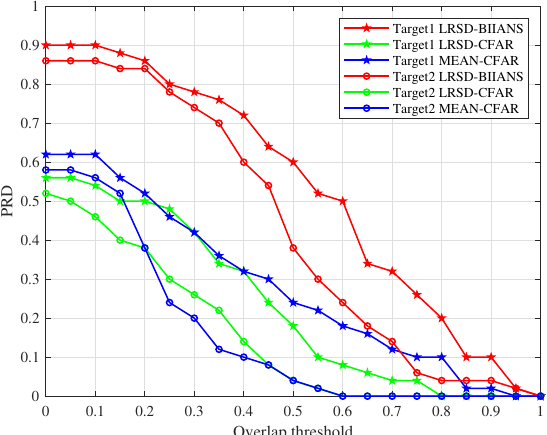
Figure 12. Comparison of detection integrity of different methods. Compared with those, the PRD value of the LRSD-BIIANS method is 60%. On the other hand, the red curve descends more slowly than the blue curve and the green curve, indicating the overlapping area between the target correctly detected by the LRSD-BIIANS method and the ground truth is larger than that detected by other methods.